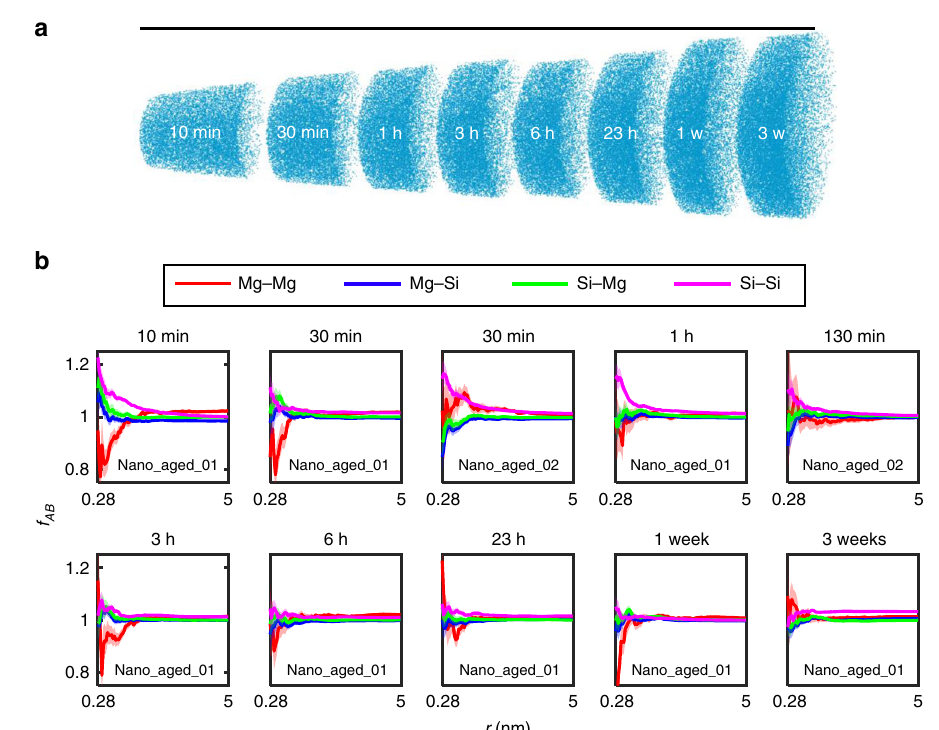
Fig. 2 In situ natural aging of atom probe samples from a quenched AlMgSi alloy (nano aging). a Mg atom positions for the concatenated runs of the sample nano_aged_01 are shown to illustrate the measurement procedure. The scale bar length corresponds to 512 nm. b Analysis of the spatial positions of solute atoms for the samples nano_aged_01 and nano_aged_02. Shown is the ratio of the cumulative sums of the radial distribution function f AB ð r Þ (Eq. (1)) for the given interactions (Mg – Mg, Mg – Si, Si – Mg, and Si – Si) and nano aging times. Values f AB > 1 indicate clustering (for details see Supplementary Note 2 and Supplementary Table 1). No signi fi cant increase of the signals can be observed for increasing (in situ) natural aging times. Error bar boundaries are calculated according to Supplementary Eqs. (7) and